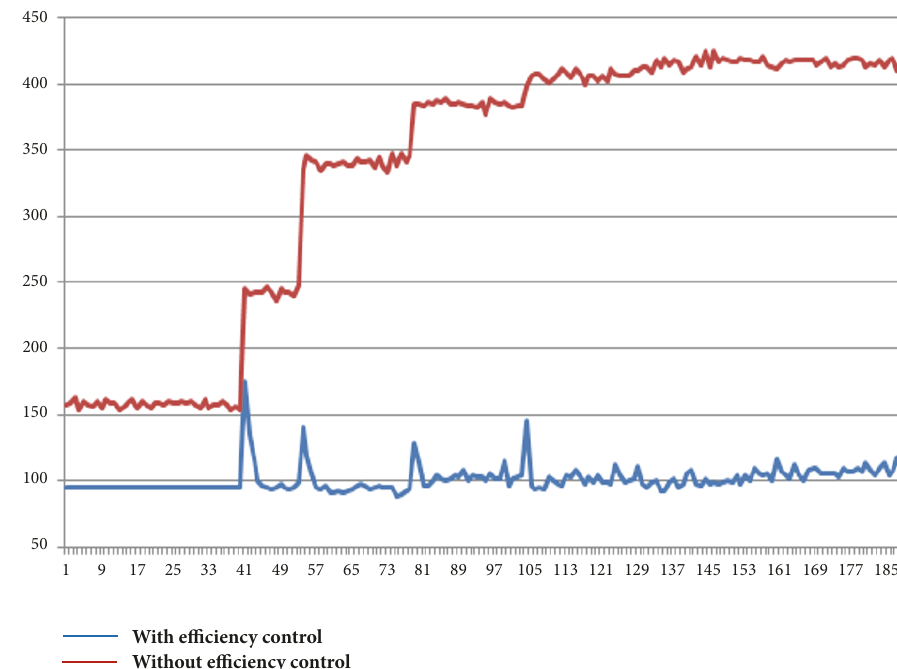
Figure 11: Efficiency curve of the second experiment. Vertical axis indicates the time cost ( ms ); the horizontal axis indicates the animation